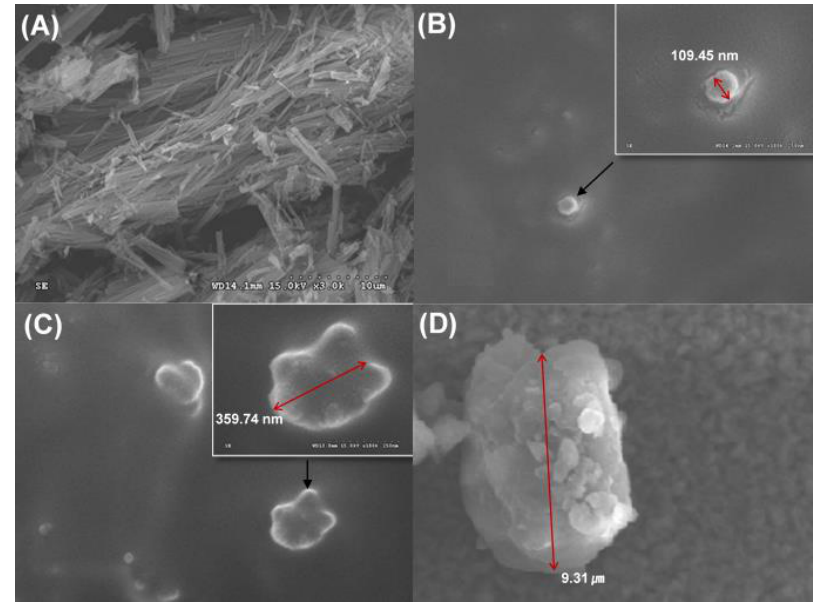
Figure 5. SEM images of raw PPD ( A ), a dispersion particle of F9 ( B ) and F12 ( C ), and a precipitation particle of F4 ( D ).